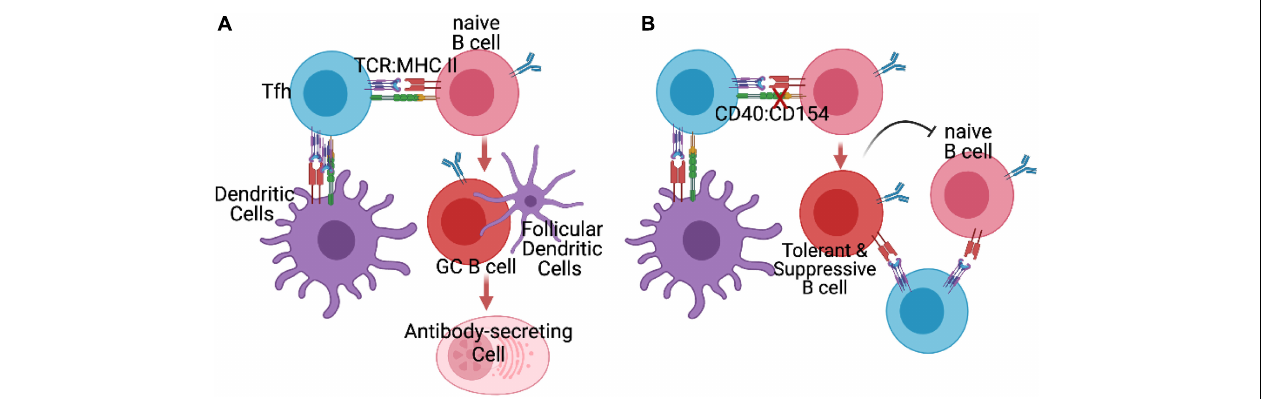
FIGURE 1 | (A) In untreated recipients of allografts, Tfh cells generated by initial encounter with recipient dendritic cells presenting alloantigen engage to provide help to naïve alloreactive B cells, and facilitate their differentiation into germinal center (GC) B cells and antibody-secreting plasmablasts and plasma cells. (B) In the presence of blocking anti-CD154 (X), naïve alloreactive B cells fail to receive signals from CD40 and thus differentiate into tolerance-induced B (TIB) cells incapable of differentiating into GC B cells or antibody-secreting cells. Instead these B cells acquire the ability to prevent naïve donor-specific B cells from differentiating into germinal center or antibody-secreting cells, by as yet to be defined